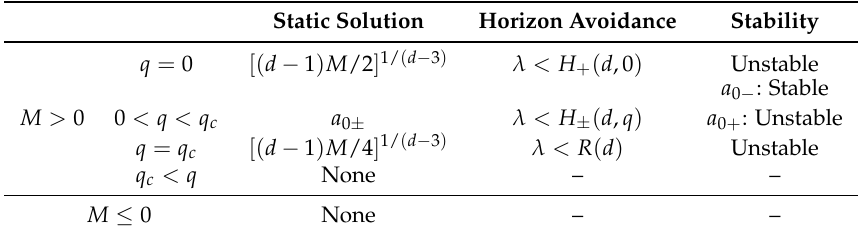
Table 2. The existence and stability of static wormholes in spherical symmetry in four and higher dimensions.